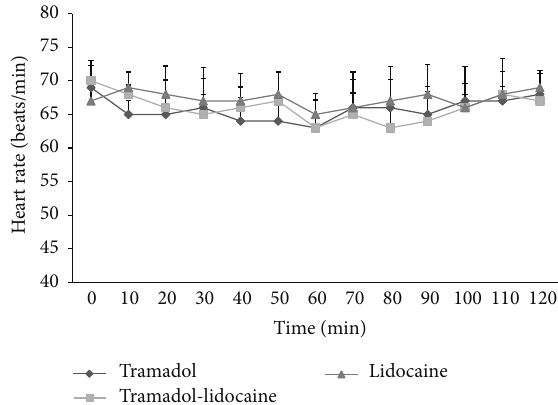
Figure 3: Mean heart rate (beats/minute) after epidural analgesia of tramadol, tramadol-lidocaine combination, and lidocaine in buffalo calves (mean ± SD in 10 calves). Error bars indicate the standard deviation of the mean.